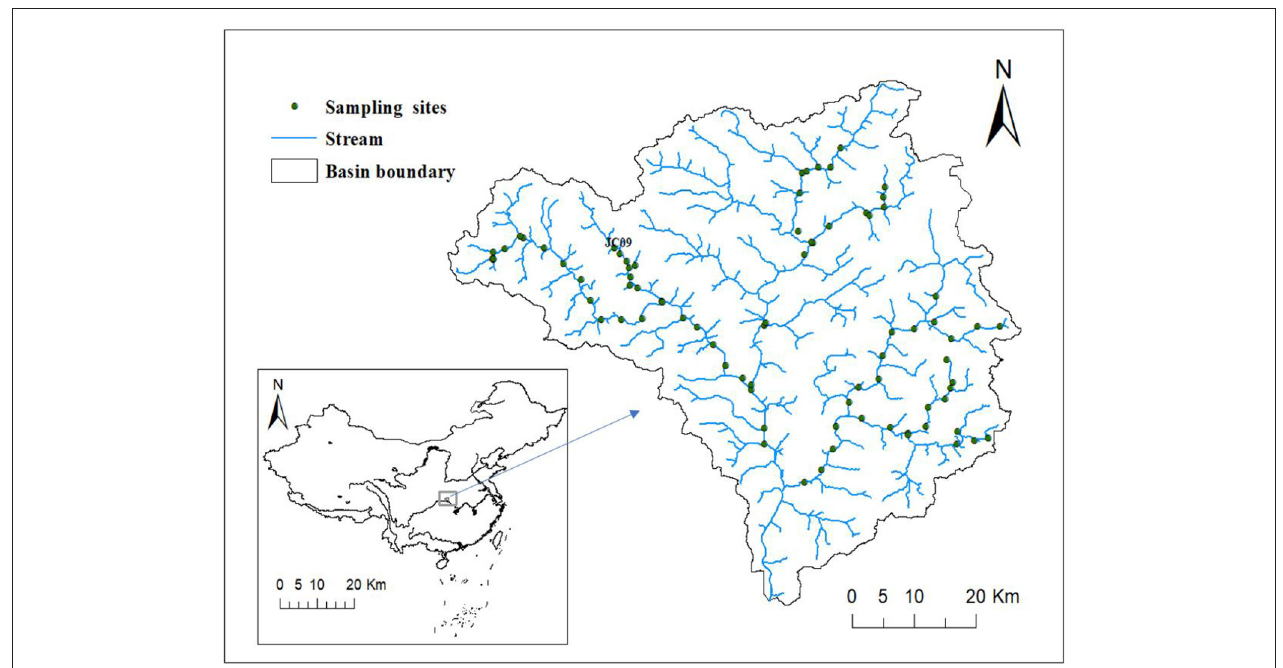
FIGURE 1 | Distribution of sampling sites in the Xiangxi River